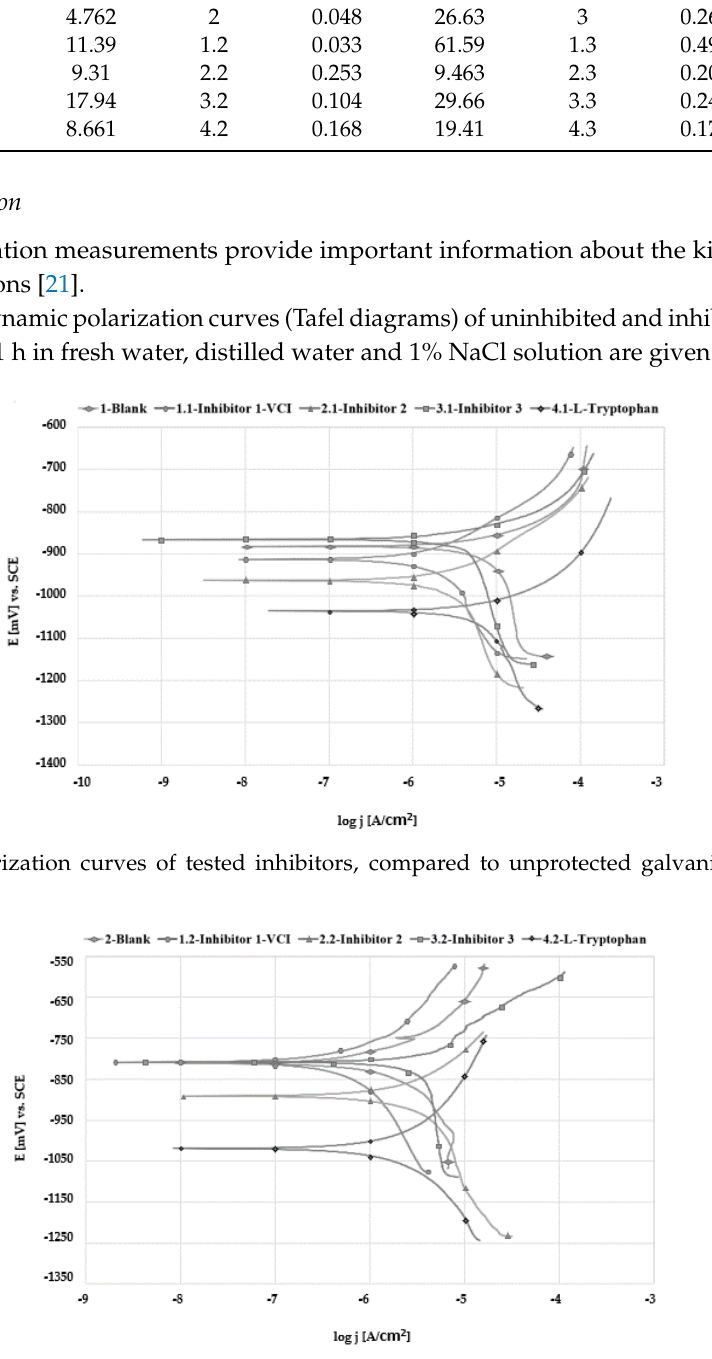
Figure 6. Polarization curves of tested inhibitors, compared to unprotected galvanized steel in 1% NaCl solution. The corrosion parameters, namely corrosion potential ( E corr ), corrosion current density ( j corr ), inhibition efficiency ( η ) , and anodic and cathodic Tafel slopes ( β a , β c ) are listed in Tables 3–5. Table 3. Polarization test results in fresh water, at a temperature (23 ± 2) °C, with and without inhibitor. Sample